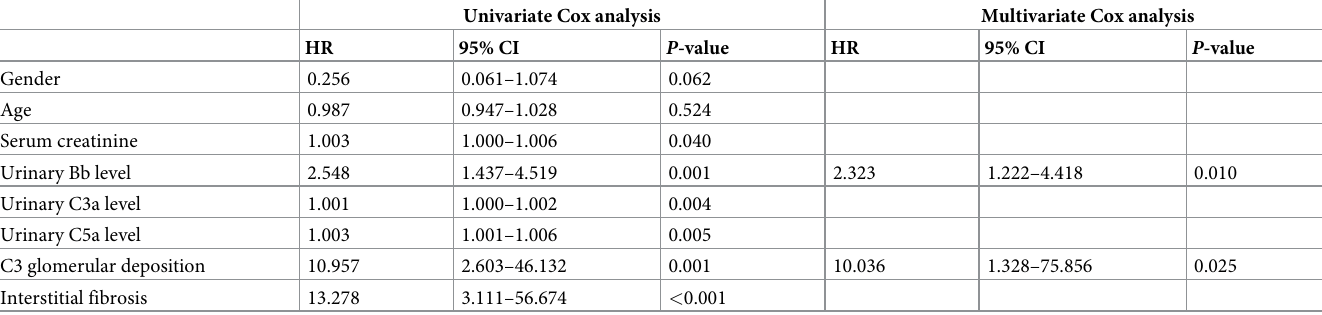
Table 4. Univariate and multivariate Cox regression analysis for the renal outcomes of primary FSGS